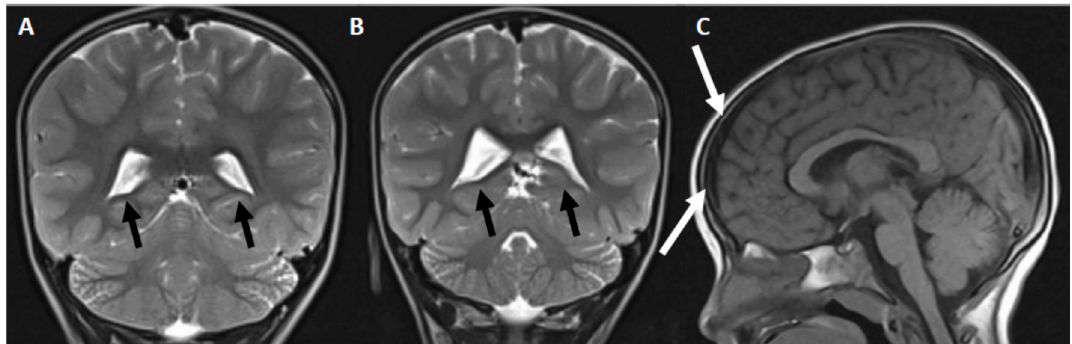
Figure 2. Brain structural alterations observed in the patient. ( A and B ) Axial, magnetic resonance, T2-weighted images showing discrete asymmetry of the lateral ventricles. Note that the right side is larger (indicated by the black arrows). ( C ) Sagittal, magnetic resonance, T1-weighted image showing discrete frontal subdural hygroma (indicated with white arrows).